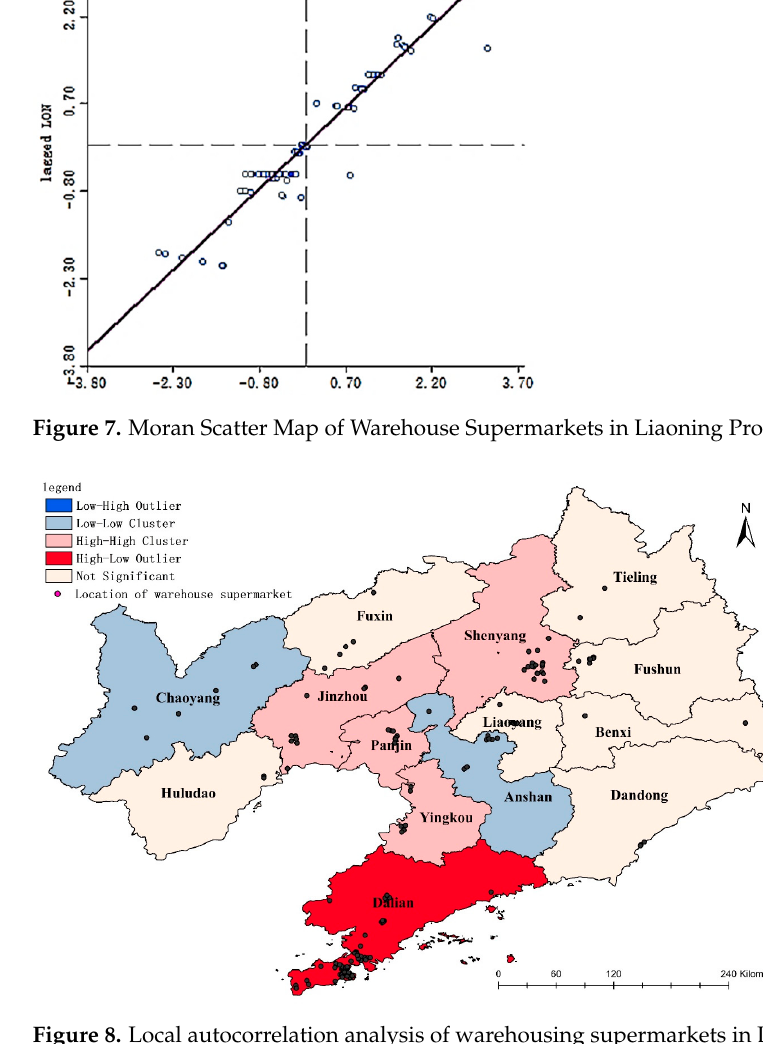
Figure 8. Local autocorrelation analysis of warehousing supermarkets in Liaoning Province.